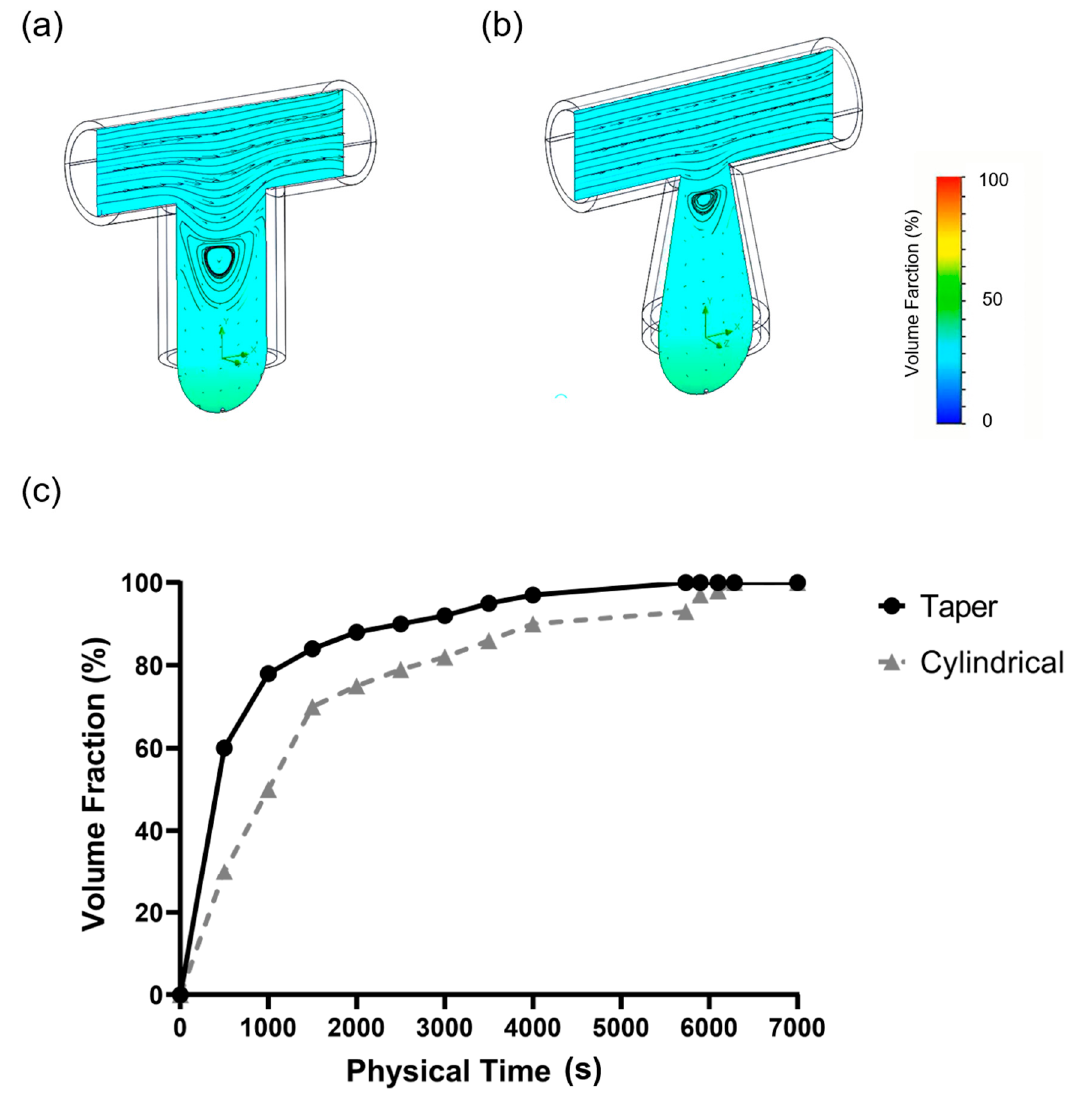
Figure 2. Model of computer simulation microfluid chip medium exchange: ( a ) Cylindrical tube microfluid chip, ( b ) taper-shaped microfluid chip, and ( c ) result of the medium exchange rate through computer simulation.